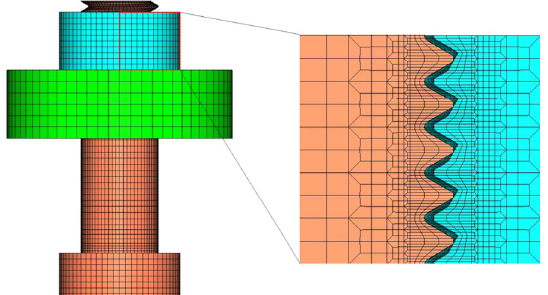
Fig. 25 FEM of engagement between regular bolt and Spiralock nut.